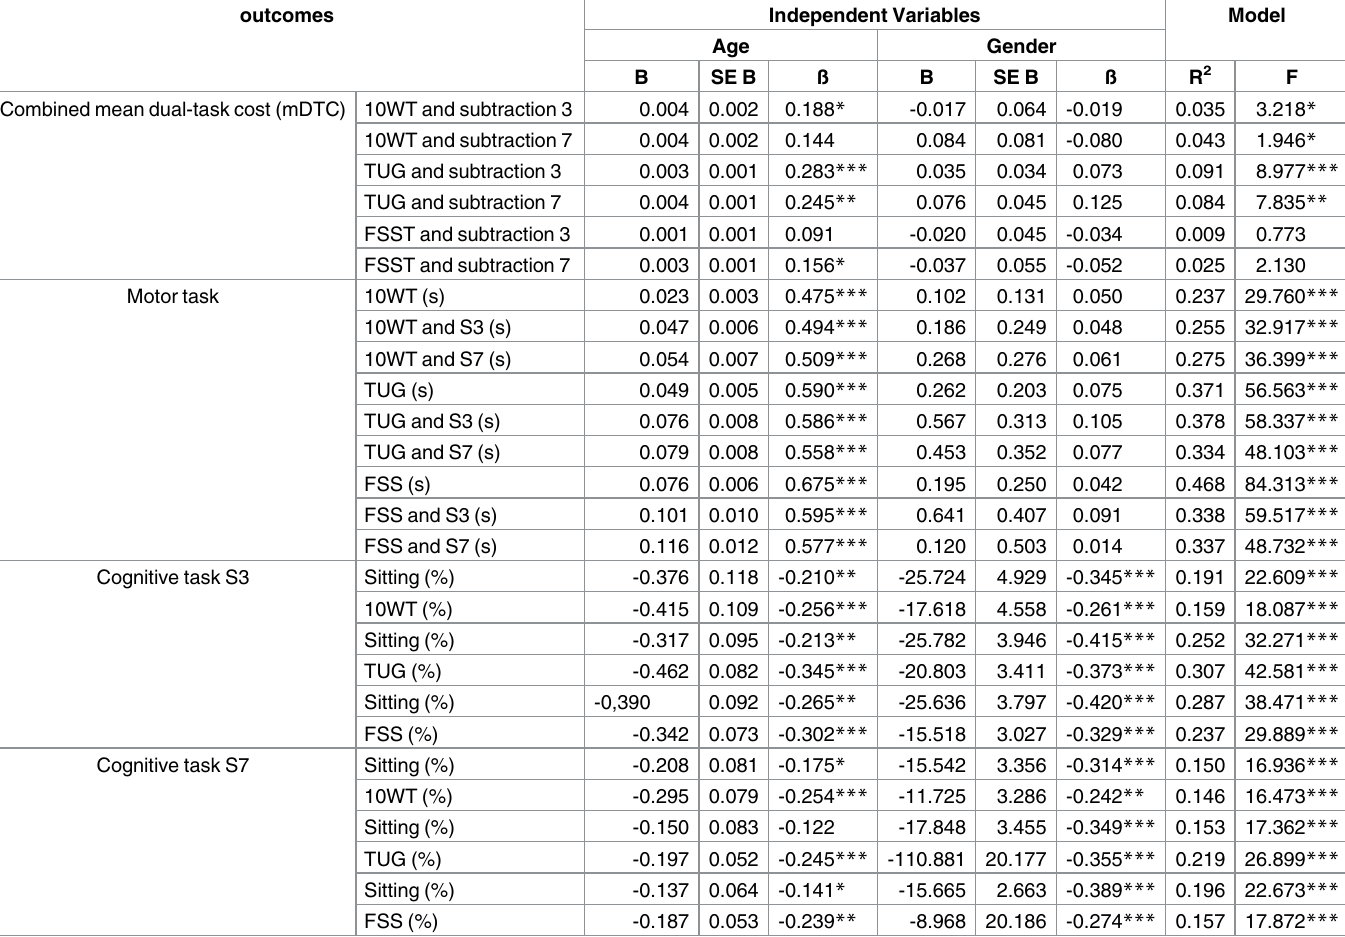
Table 2. Multiple regression model for combined mean dual-task cost, motor and cognitive